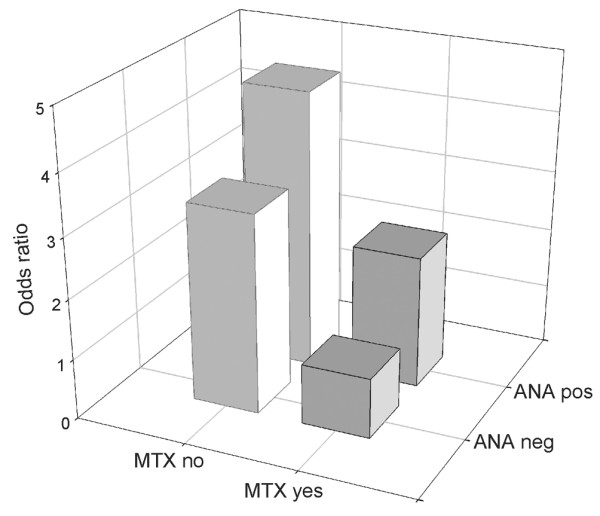
Positive predictive value for combination of baseline ANA status and methotrexate treatment for development of infusion reactions in RA patients. Values are expressed as Odds ratio adjusted for age, sex and disease duration. ANA, antinuclear antibody; MTX, methotrexate.